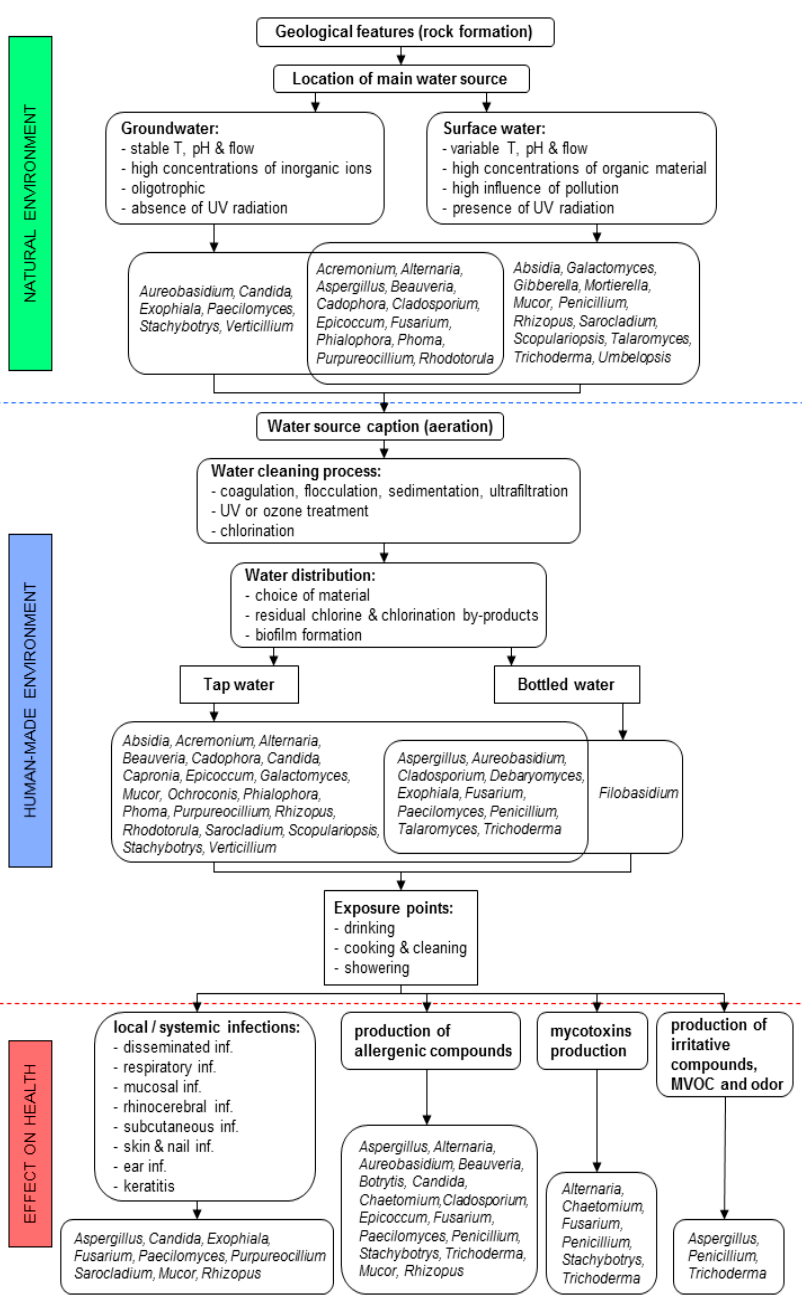
Figure 1. Abiotic, biotic and anthropogenic factors influencing fungal presence in groundwater, surface water, tap water and non-mineral bottled water, with possible effect of fungi on human health via different exposure points. The most common factors having an influence on the fungal presence and diversity in different water sources divided into factors influencing fungal presence, mainly in raw water sources in the natural environment (indicated with green colour), anthropogenic factors influencing fungal presence during production of tap and non-mineral bottled water, and exposure points of fungi via water-related activities (indicated with blue colour). Red colour indicates the most frequently detected fungal genera from tap and bottled water with their possible effects on human health.